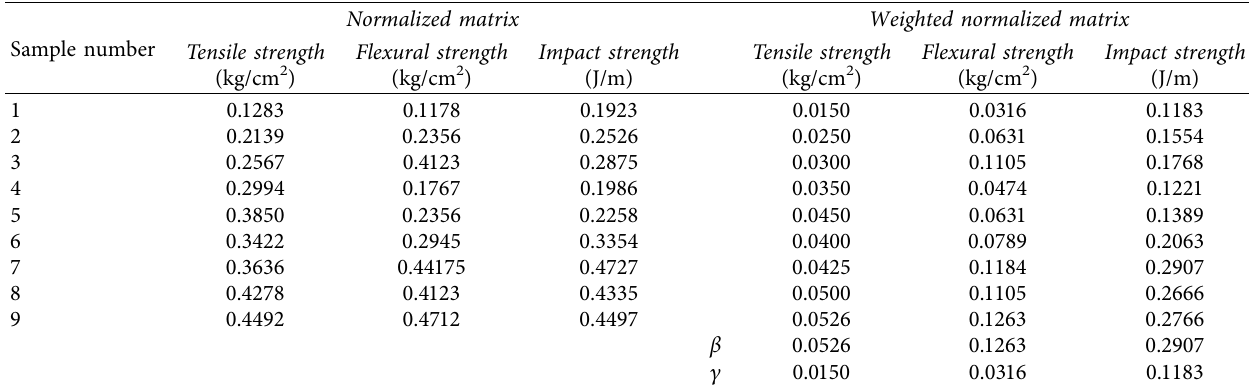
Table 5: Normalized and weighted normalized matrices.